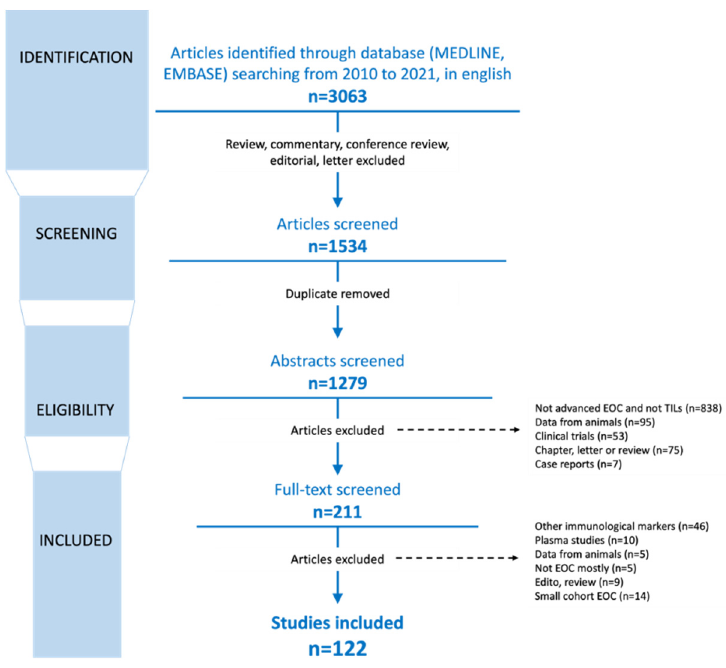
Figure 1. Schematic diagram of the selection process for the studies included in this review. Review according to Moher [21], EOC: epithelial ovarian cancer.